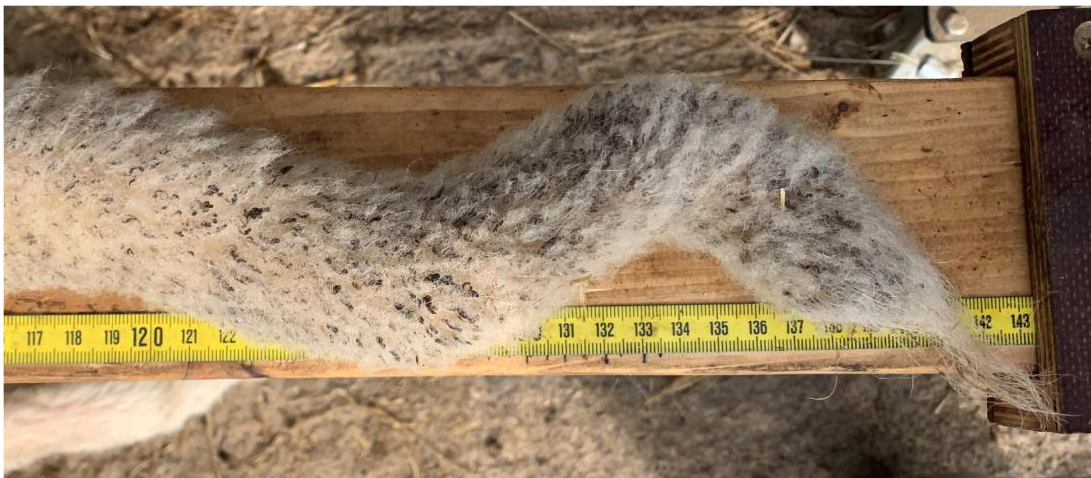
Figure 1. Sheep tail with axial deviation.